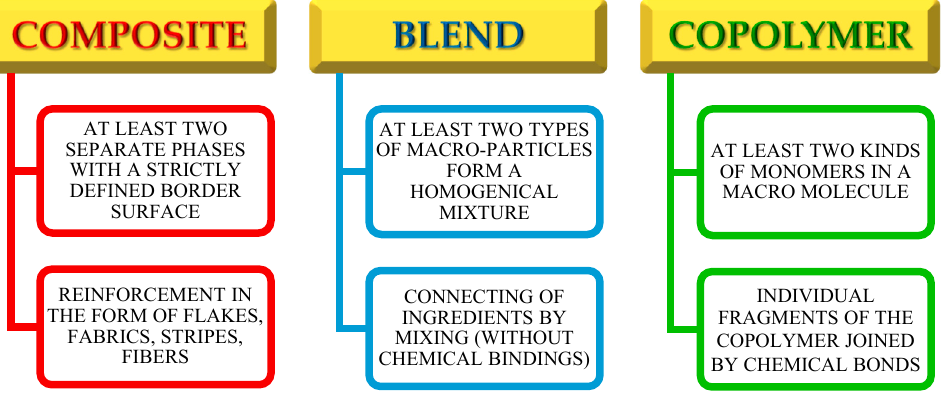
Figure 1. The most important features that distinguish composites, blends and copolymers.